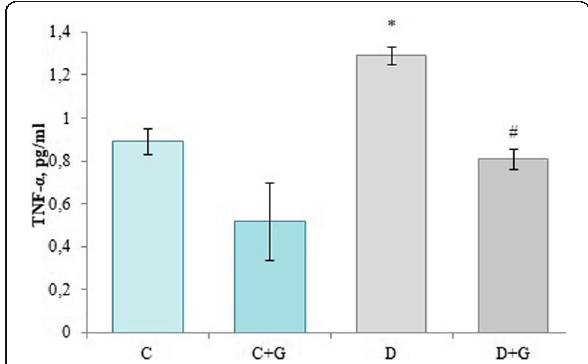
Fig. 3 Effect of Galega officinalis extract on the level of TNF- α in plasma of healthy and diabetic